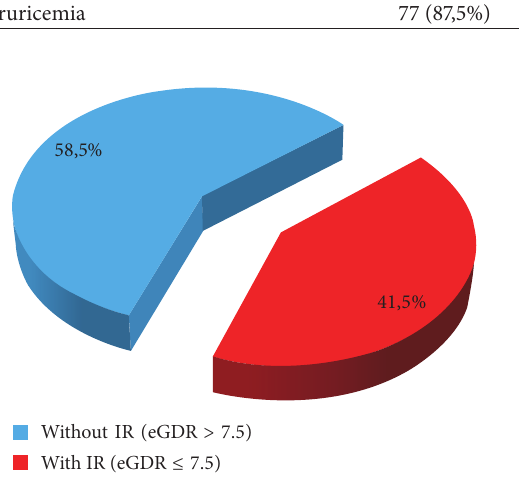
Figure 1: Insulin resistance in type 1 DM patients.